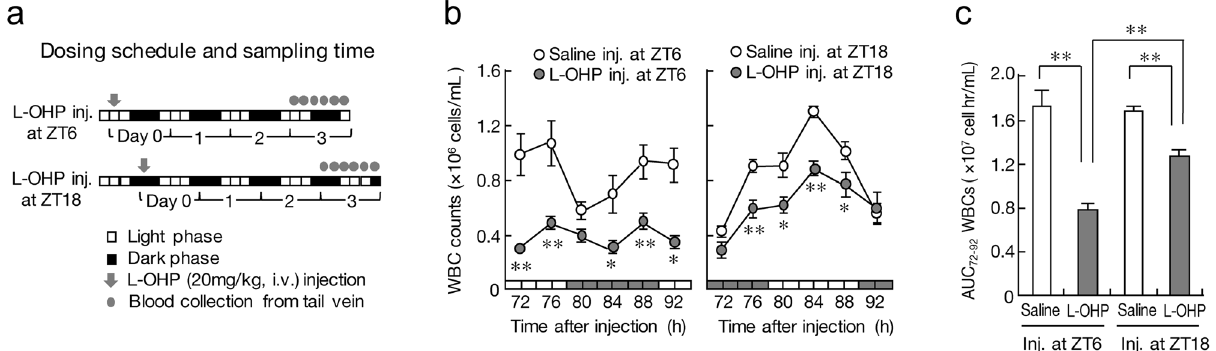
Figure 4. Dosing time-dependent change in L-OHP-induced leukopenia in mice. ( a ) Schematic experimental procedure for evaluating the dosing time dependency of L-OHP-induced leukopenia. Mice were injected with L-OHP (20 mg/kg, i.v.) or saline at ZT6 and ZT18. The number of peripheral WBCs was assessed from 72 to 92 h (4-h intervals) after L-OHP injection. ( b ) Temporal profiles of the number of peripheral WBCs in mice after injecting L-OHP (20 mg/kg, i.v.) or saline at ZT6 (left) or ZT18 (right). The horizontal bar at the bottom indicates the light and dark cycles. Values are the mean with S.D. (n = 6). ** P < 0.01, * P < 0.05, significant difference from the saline-injected group at the corresponding time point. ( c ) Comparison of the value of AUC 72–92 in the number of peripheral WBCs after injecting L-OHP (20 mg/kg, i.v.) or saline at ZT6 or ZT18. Values are the mean with S.D. (n = 6). ** P < 0.01, significant difference between the two